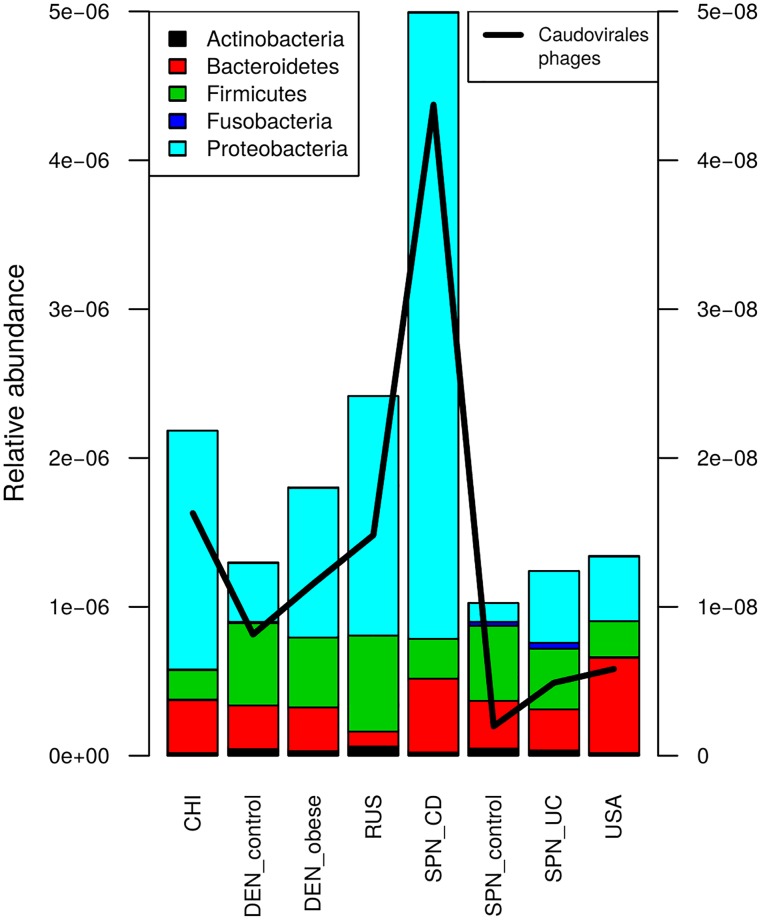
Taxonomic diversity and mean abundance of phages.Stacked bars indicate denote abundance of phages with different host taxonomy (represented with color) in the gut metagenomes according to the terminase large subunit profiling (left vertical axis). The relative abundance of tailed phages is shown separately as a black line (right vertical axis).